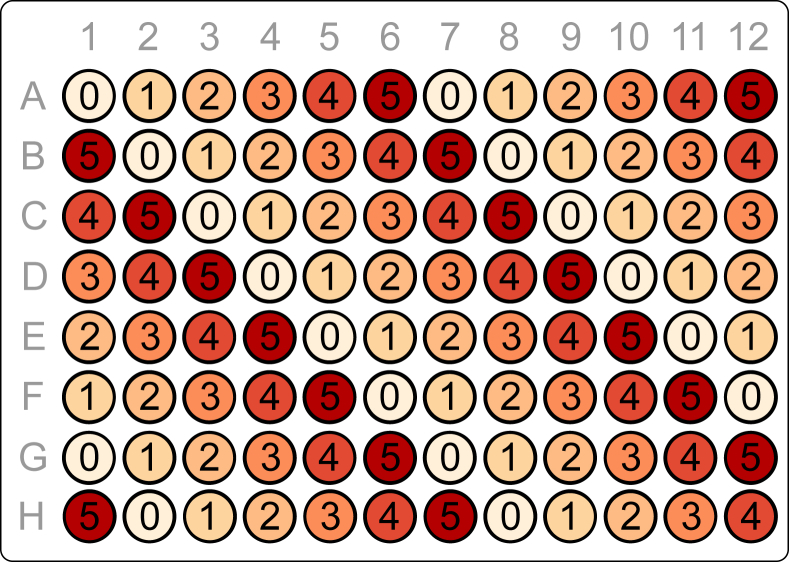
Placement of embryos in each 96-well plate, where each well is denoted by treatment group ranging from control (0) to the highest tested chemical concentration (5).